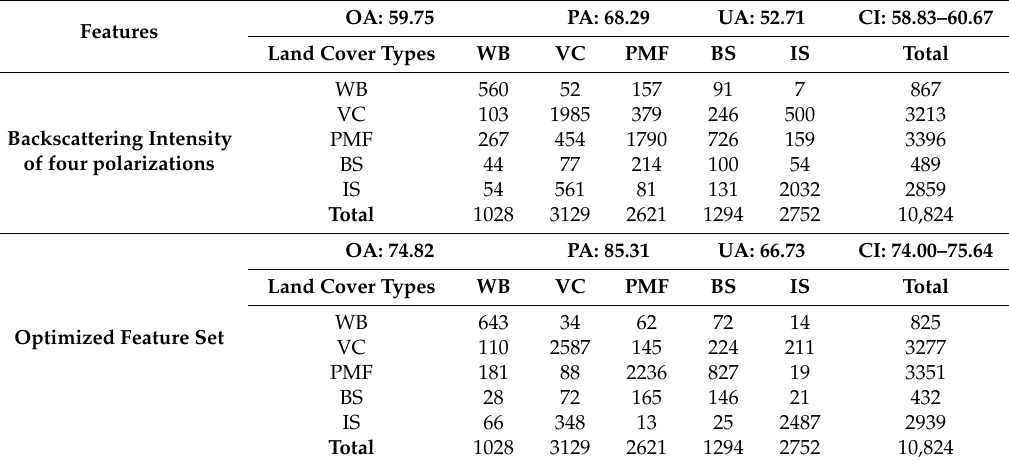
Table 7. The confusion matrix from RF in